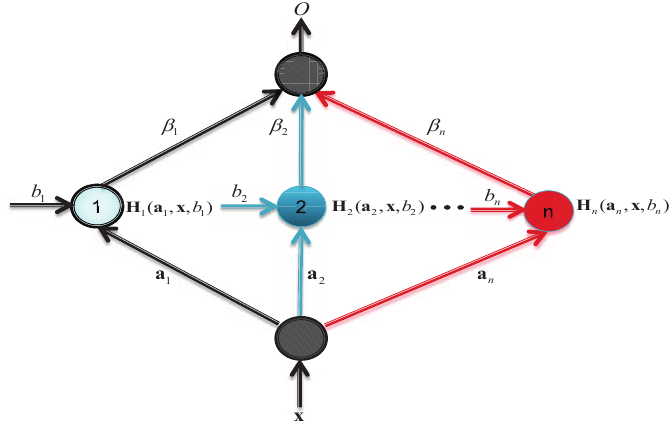
Figure 3. The I-ELM